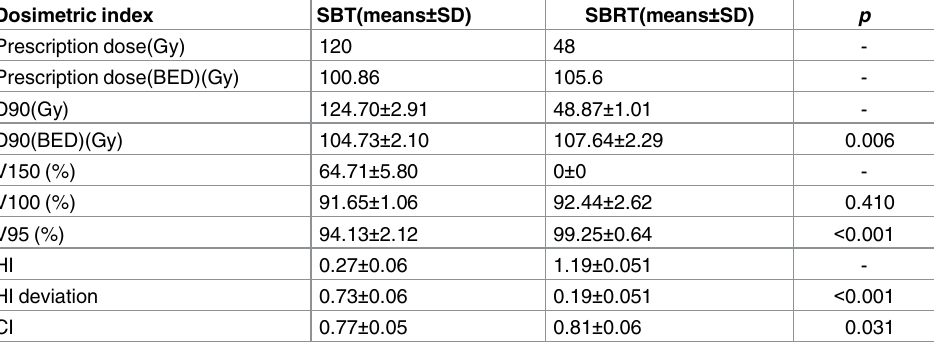
Table 2. Dosimetric parameters comparison between SBT and